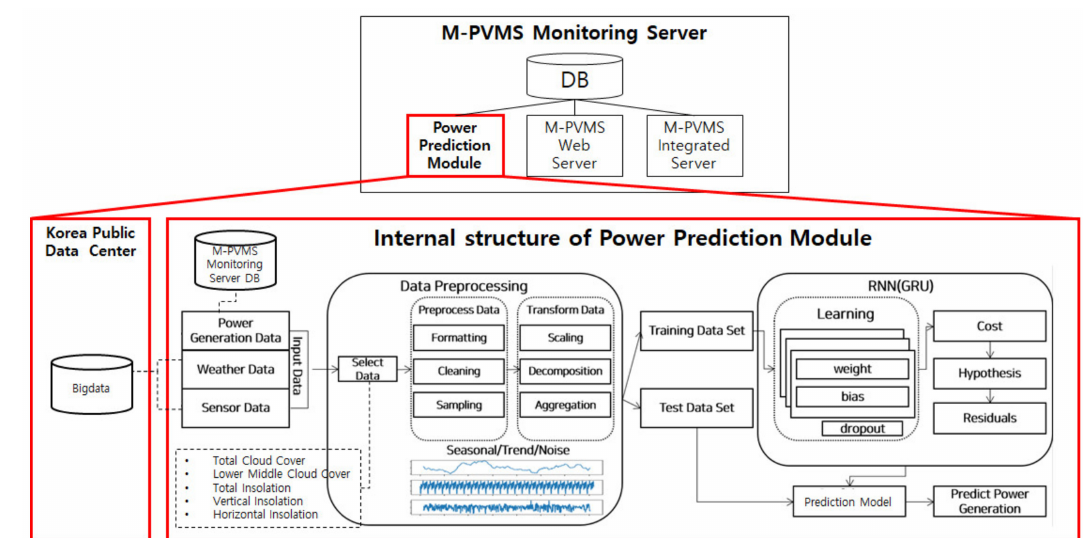
Figure 11. Structure of power prediction